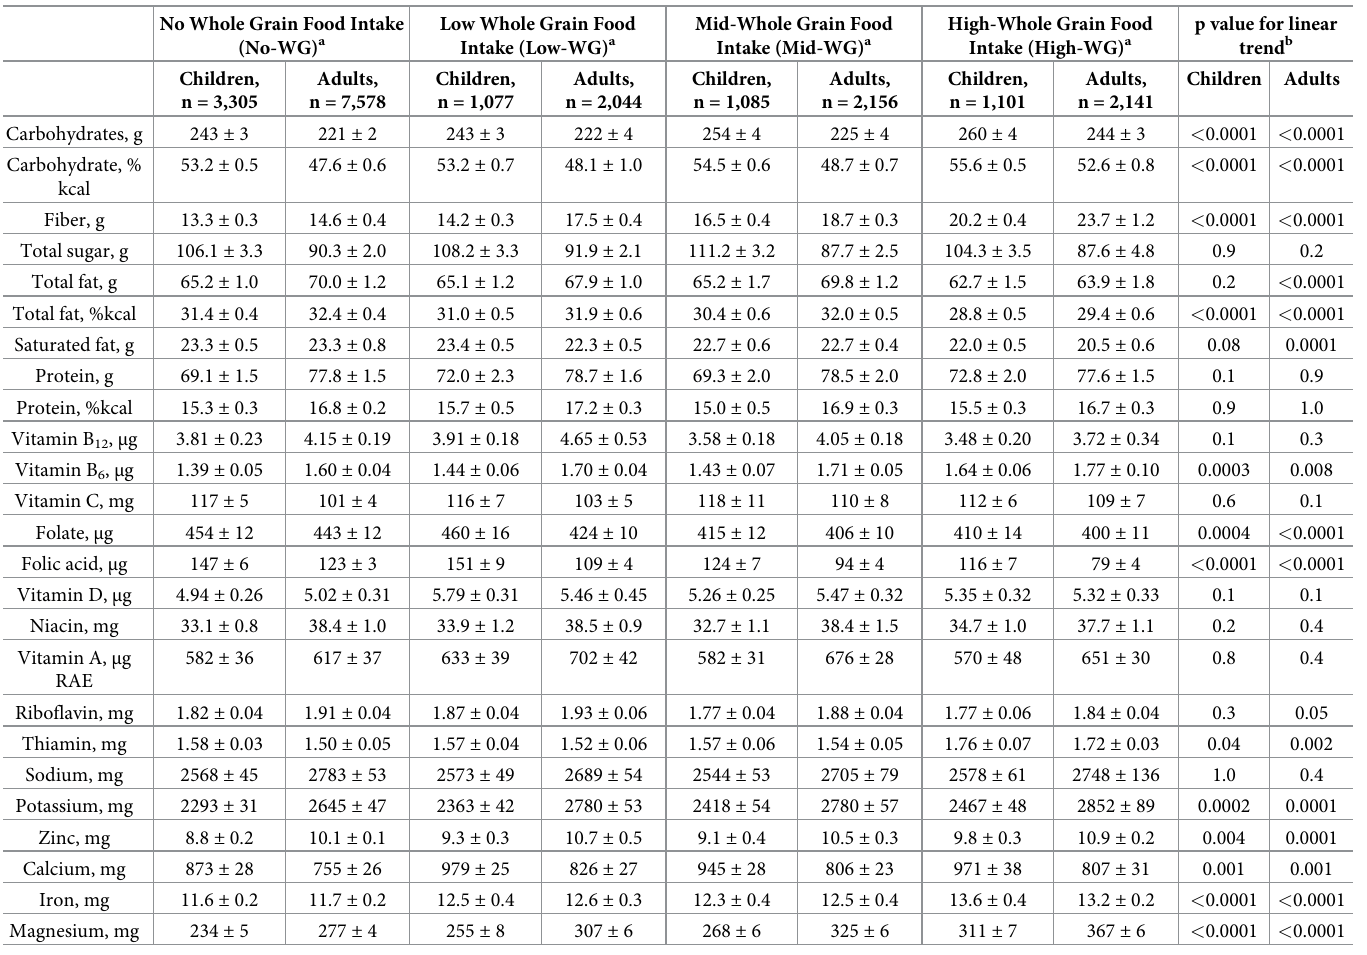
Table 2. Adjusted daily nutrient intakes for Canadian children and adults stratified by whole grain food intake. No Whole Grain Food Intake (No-WG)